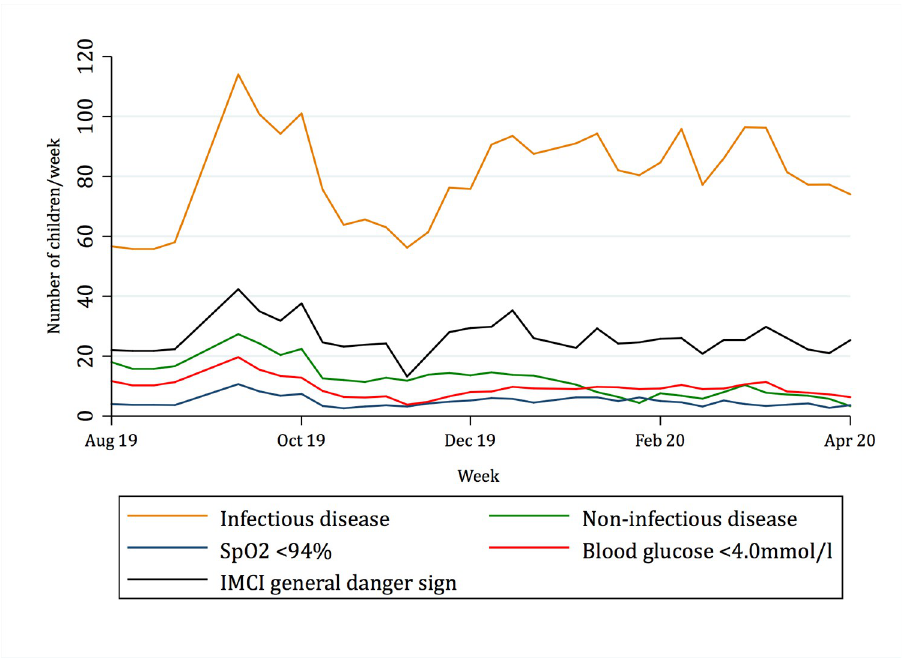
Fig 2. Seasonality of infectious disease, non-infectious disease, IMCI danger signs, SpO 2 < 94% and blood glucose < 4.0mmol/l.